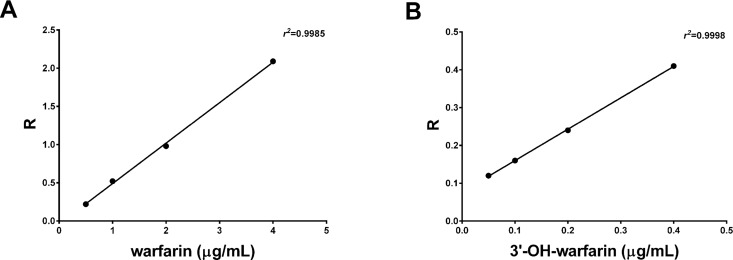
HPLC calibration curves.Warfarin (1A) and 3’-hydroxywarfarin (1B) calibration curves; R expresses the ratio between the area under the analyte peak (warfarin or 3’-hydroxywarfarin respectively) and the area of the internal standard.